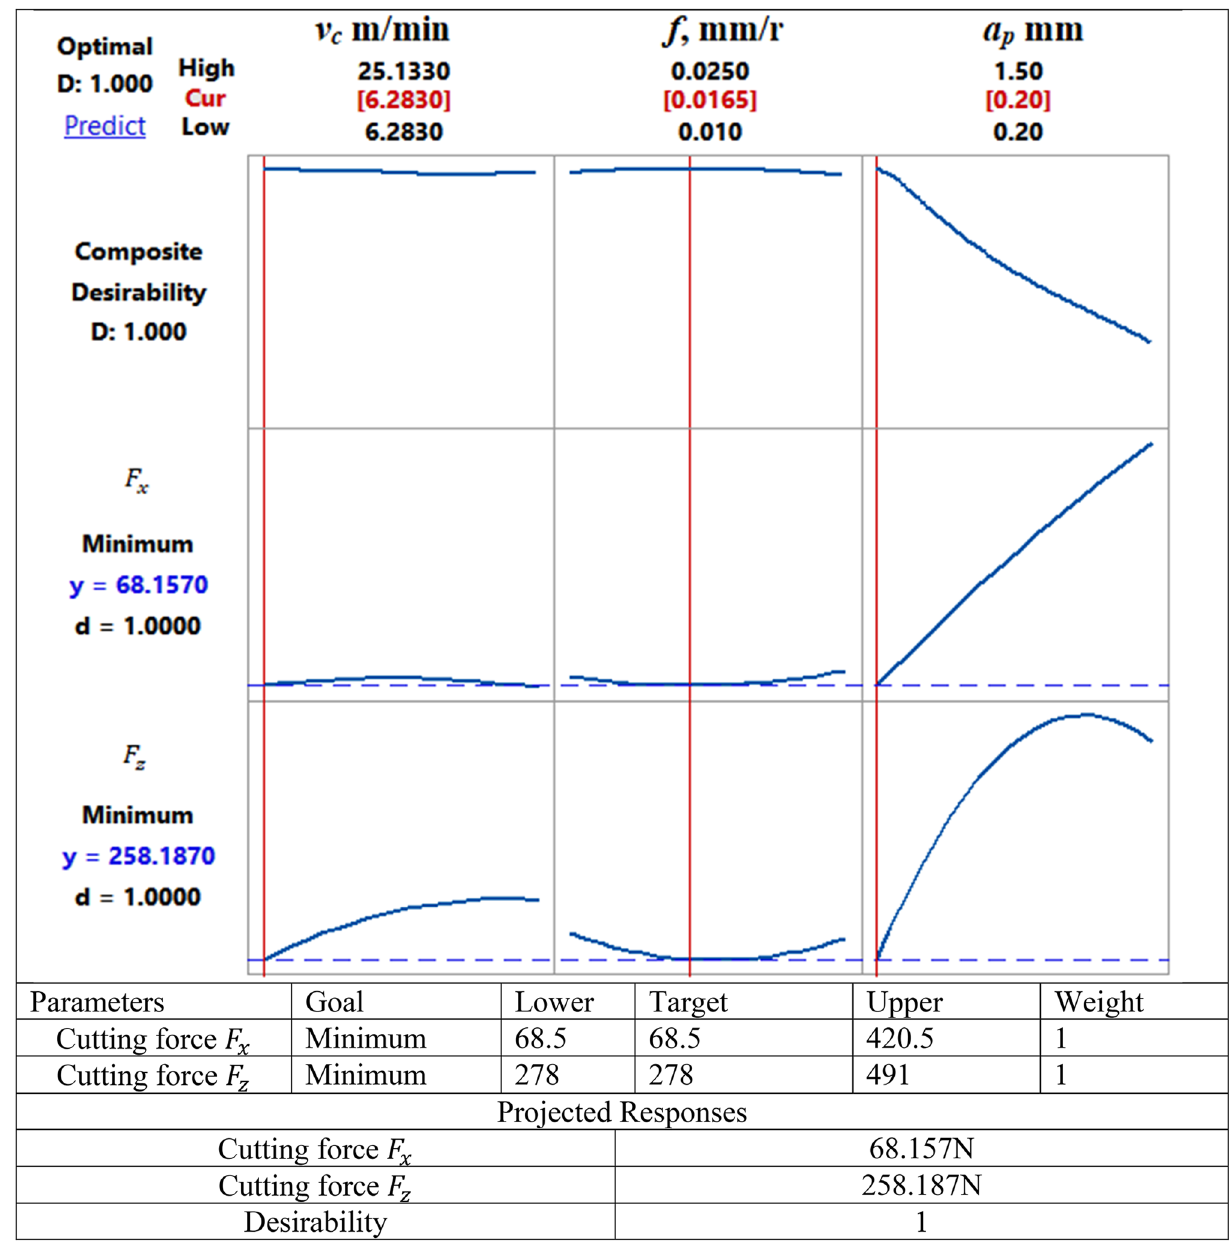
Fig. 19 Optimization Plots of Cutting Force F x and F z SiCp/Al